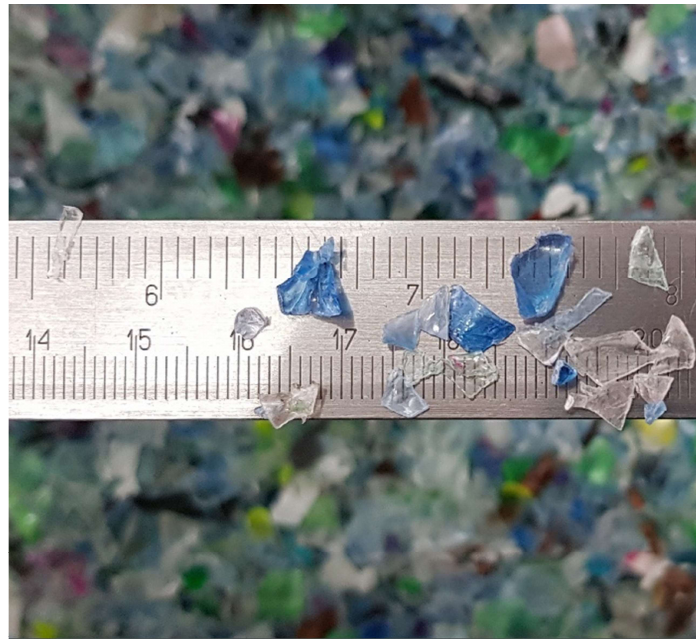
Figure 1. PET flakes. Figure 1. PET Quartz sand with a maximum particle diameter of 2 mm was used. The sand was characterised by a specific gravity of 2.65 g/cm 3 . GGBFS with a dry bulk density of 150 kg/m 3 , sourced from Merox (Sweden), was utilised as a binder. Its chemical composition is shown in Table 2. Table 2. Chemical composition of GGBFS. Oxide Type